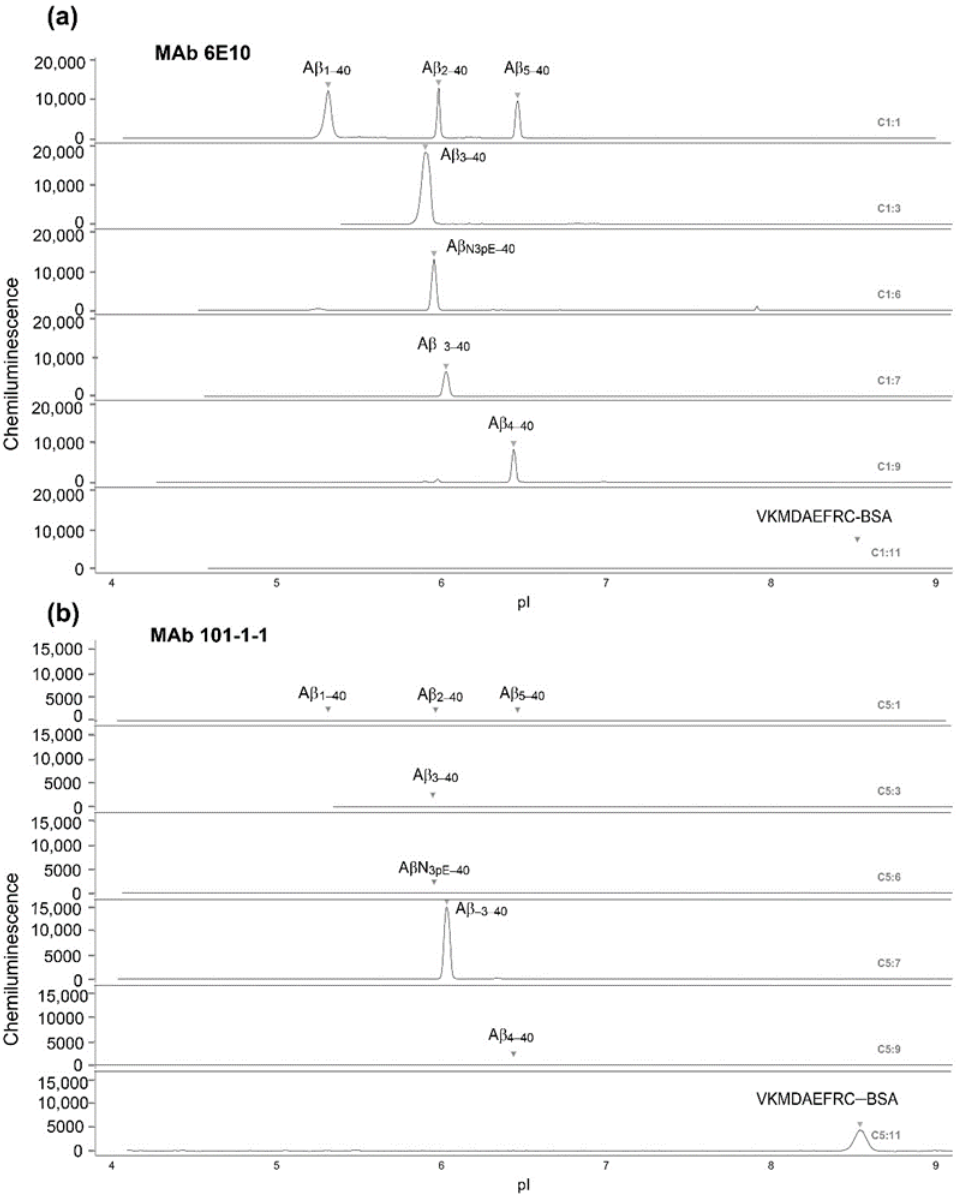
Figure 2. Monoclonal antibody 101-1-1 recognizes Aβ −3–40 with high selectivity on capillary isoelectric focusing immunoassay. A series of synthetic Aβ peptides with different N-termini was separated by isoelectric focusing in microcapillaries, immobilized by a photochemical reaction, and probed with ( a ) mAb 6E10 (2 µg/mL) or ( b ) mAb 101-1-1 (2.1 µg/mL). Chemiluminescent detection was achieved with biotinylated goat-anti mouse IgG antibody in combination with streptavidin-HRP (streptavidin horseradish peroxase conjugate) and chemiluminescent substrate. The specific Aβ variants loaded in the different capillaries as single peptides or in mixtures are indicated. Aβ 1–40 , Aβ 2–40 , Aβ 3–40 , Aβ 4–40 , Aβ 5–40 , and Aβ −3–40 were loaded at a concentration of 100 ng/mL. The tested concentration of Aβ N3pE–40 and VKMDAEFRC-bovine serum albumin (BSA) was 200 ng /